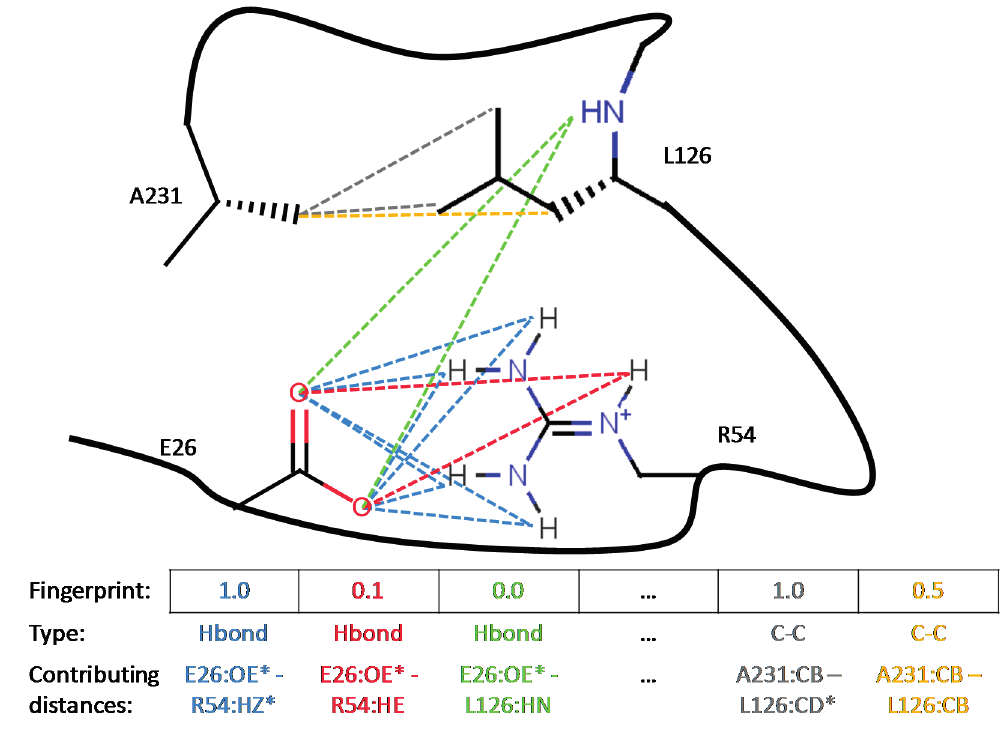
Figure 2. Principle of Interaction Fingerprints: each element represents a unique putatively favorable interaction, which may be embodied by different topologically equivalent